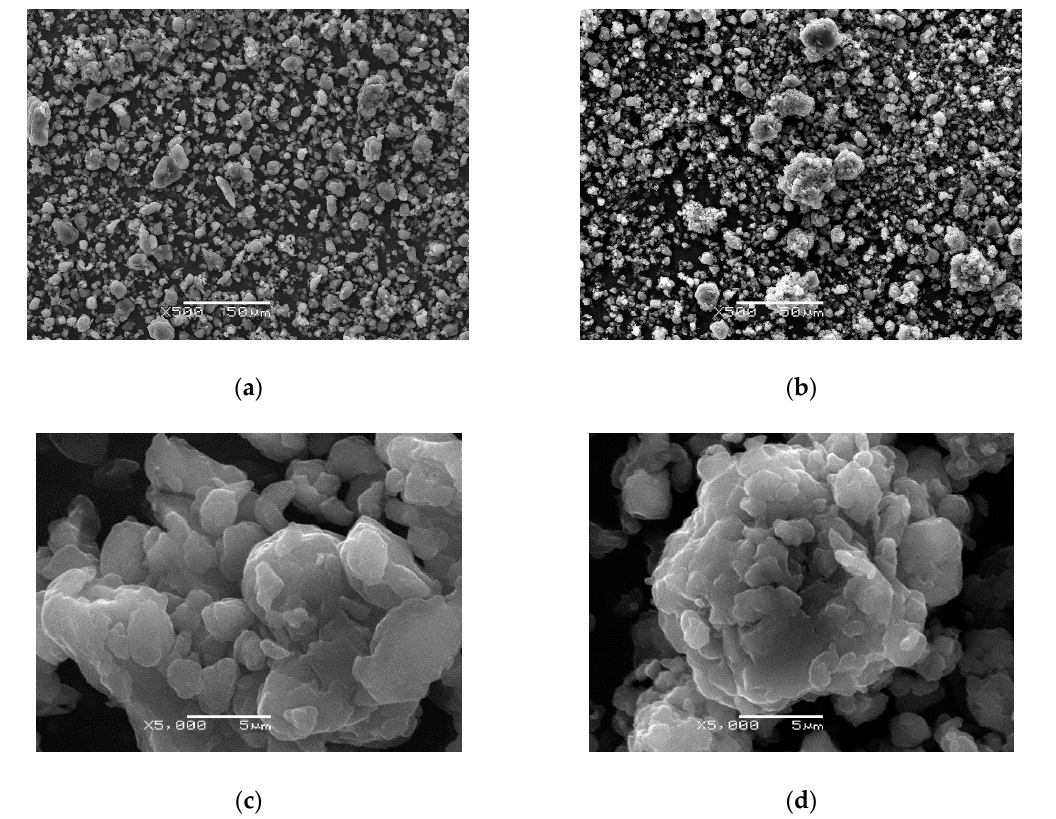
Figure 4. SEM images of the PANI synthesized with varying acid concentration: ( a , c ) PANI (1.0 M); ( b , d ) PANI (5.0 M). A 500× magnification is shown in ( a , b ), while a 5000× magnification is shown in ( c , d ).